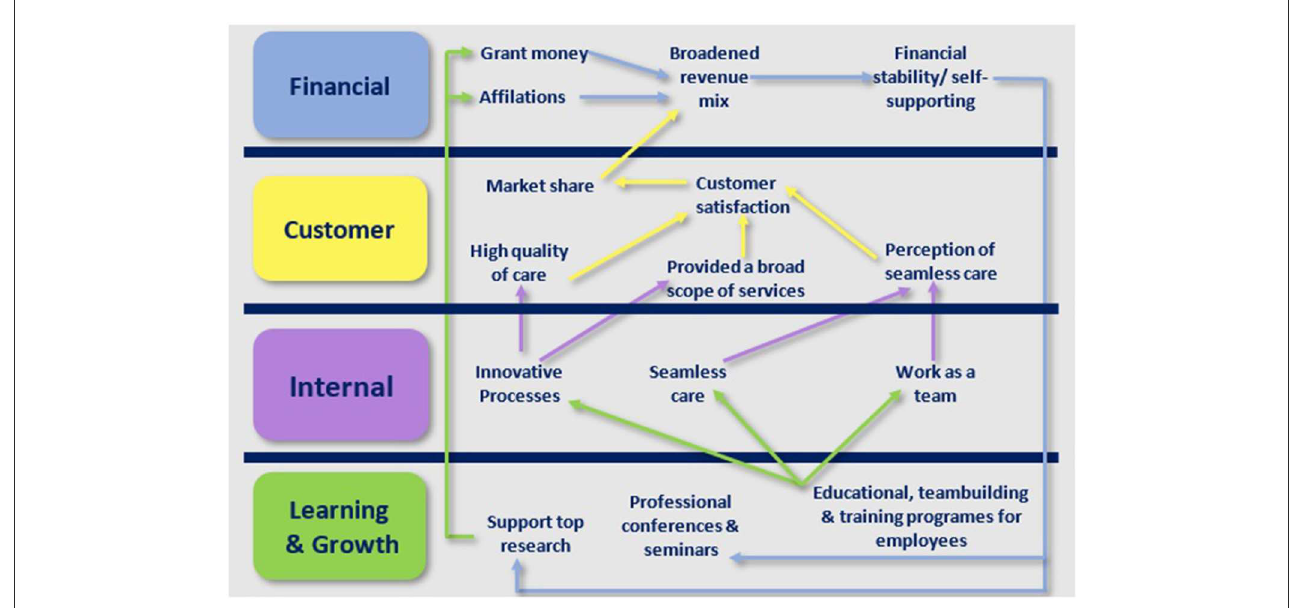
FIGURE2 Strategic map of the Duke University health system [source: (20) with